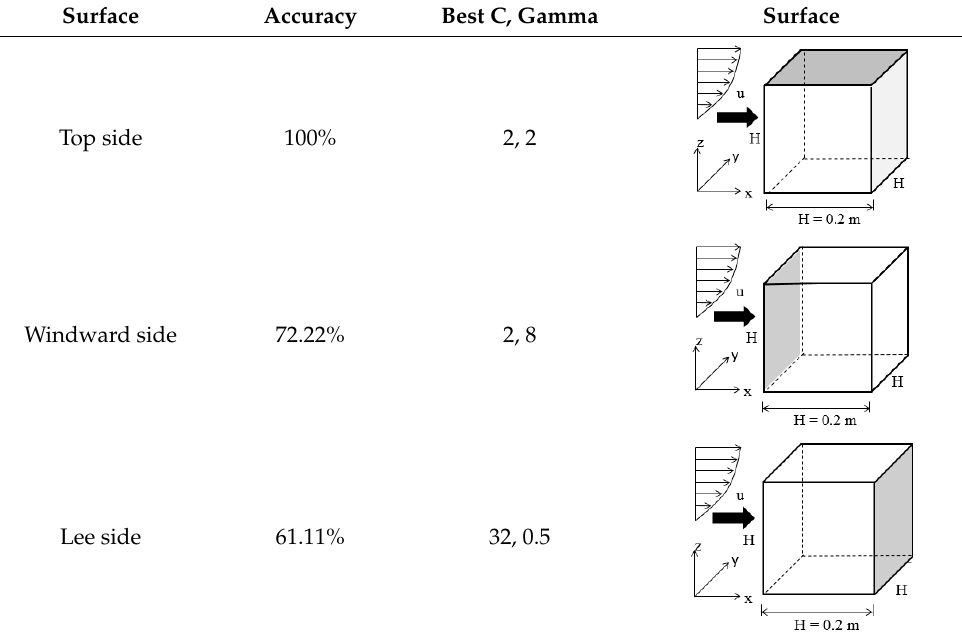
Table 7. SVM fitting models under the 30° and 45° wind direction condition.